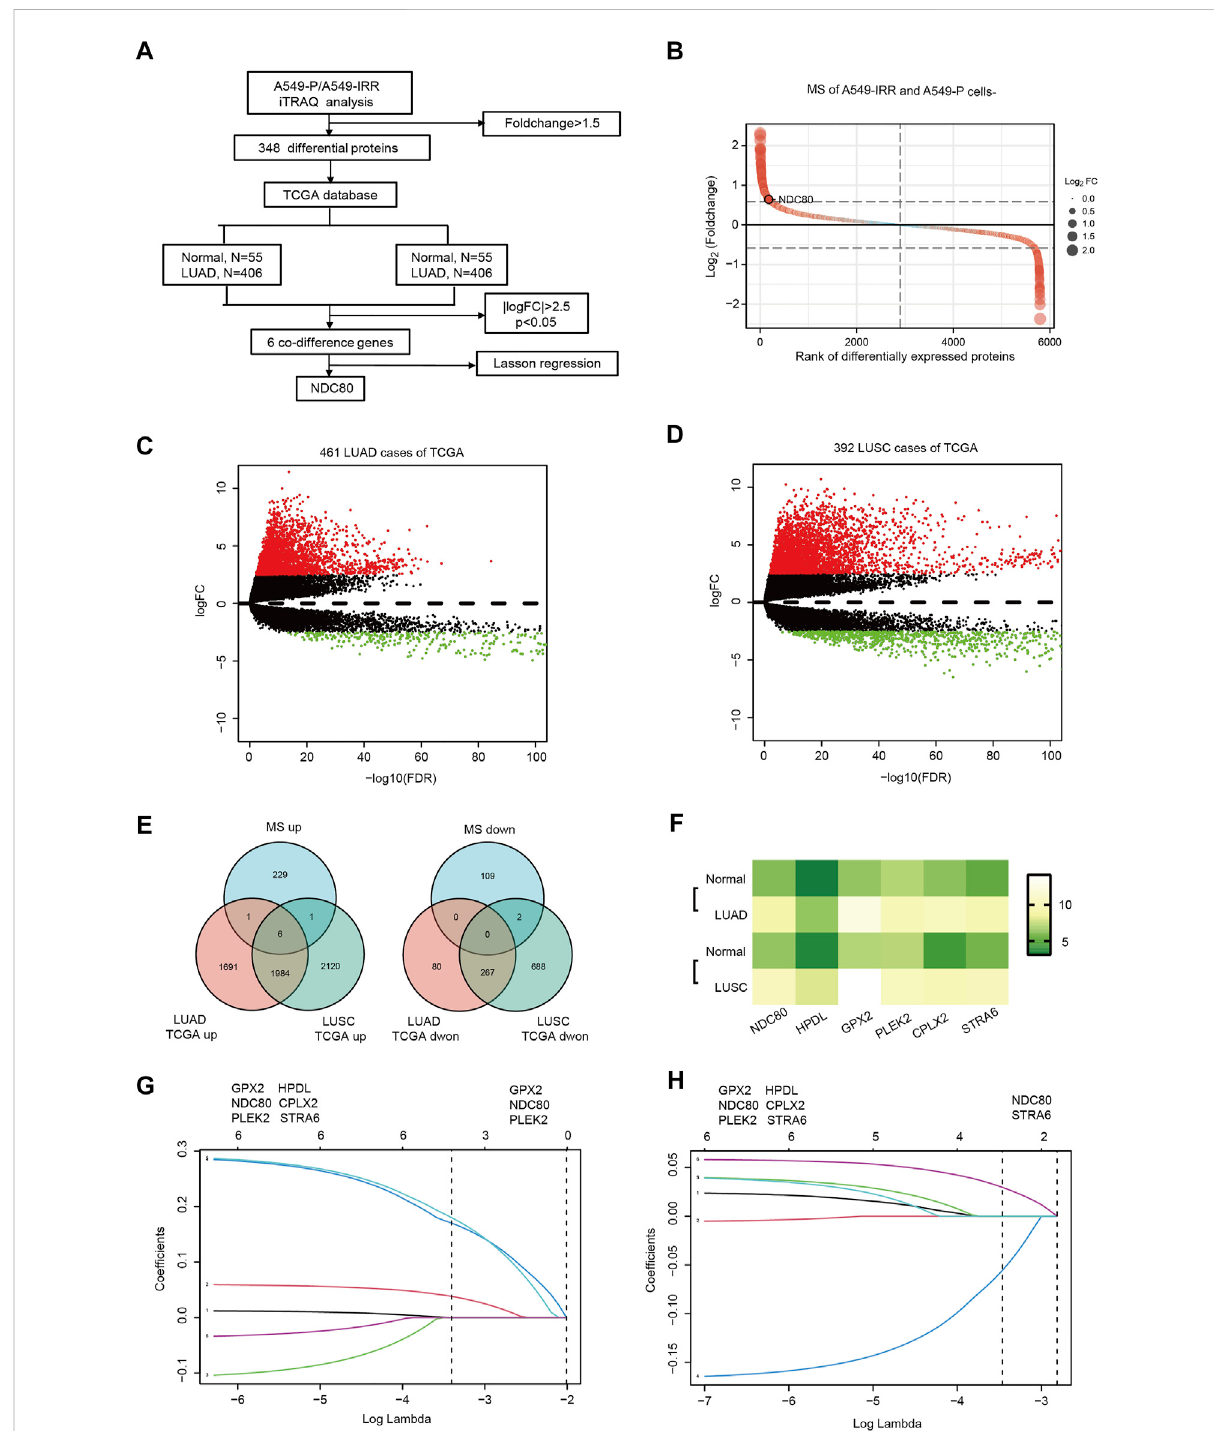
FIGURE 1 NDC80 isidenti fi ed as aradioresistance-related gene inlung cancer. (A) The fl owchart presents theprocess ofidenti fi cation of genes and their prognostic value in the LUAD and LUSC datasets. (B) iTRAQ analysis for the identi fi cation of differentially expressed proteins between A549-P and A549-IRR. (C,D) Identi fi cationofdifferentiallyexpressedgenesinLUAD (C) andLUSC (D) samples,ascomparedtopairedhealthytissuesamplesfrom the TCGA database. (E) Visualization of the co-differences in genes from the results of iTRAQ analysis and the TCGA database. The 6 overlapping genes were upregulated in A549-IRR cells and tumor tissues. (F) The heatmap shows the expression of 6 overlapping genes in the LUAD and LUSC datasets. (G,H) Prognostic genes were identi fi ed using the least absolute shrinkage method and selection operator Cox regression model(LASSO)usingdatasetsfromTCGAintheLUAD (G) andLUSC (H) datasets.Coef fi cientdistributionplotsforthelogarithmic(lambda)sequence for the selection of the best parameter